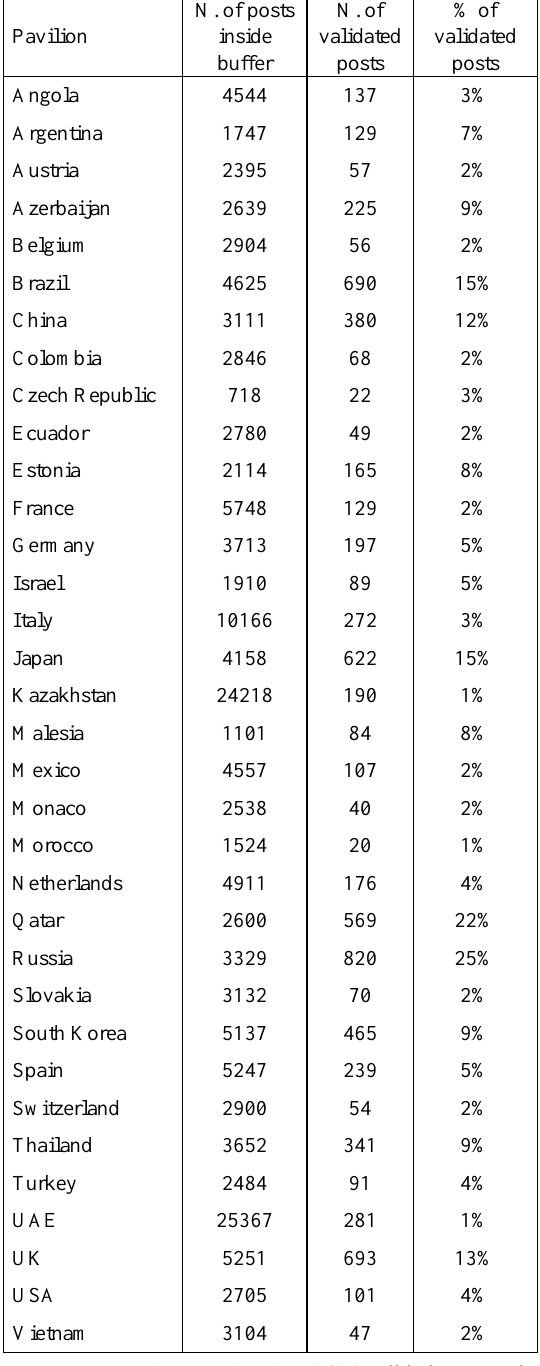
Table 2. Results of the Buffer - ‘PLACE’ validation procedure